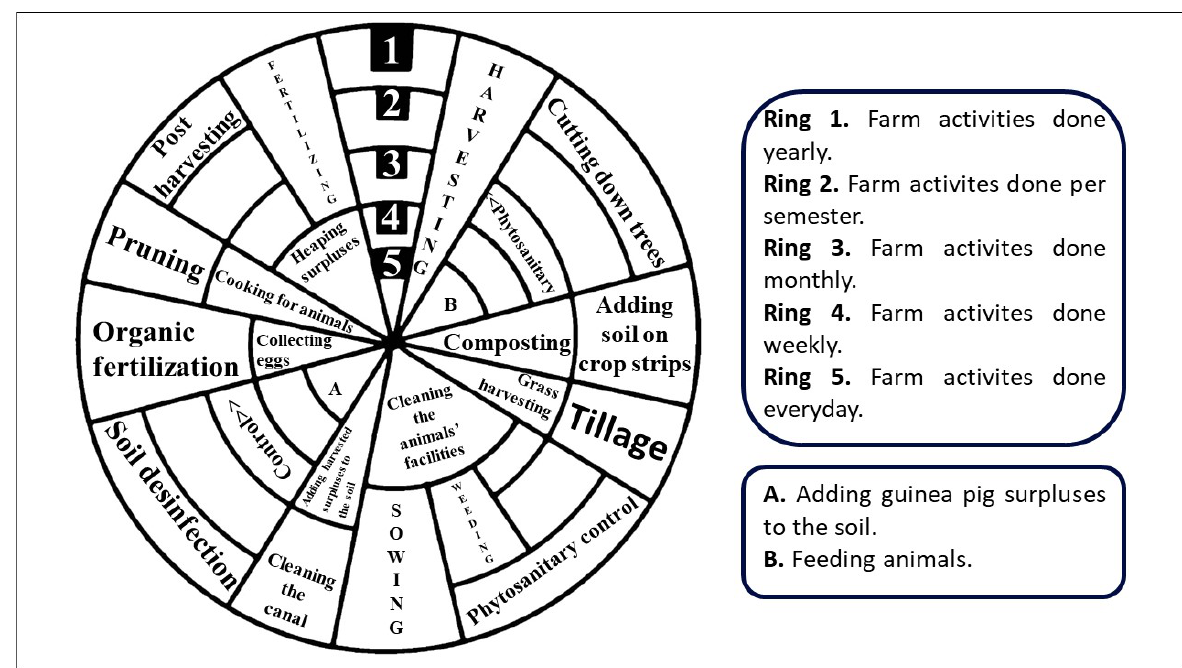
Figure 2. The most important labor activities and frequency of the management and maintenance of agrosilvopastoral systems.